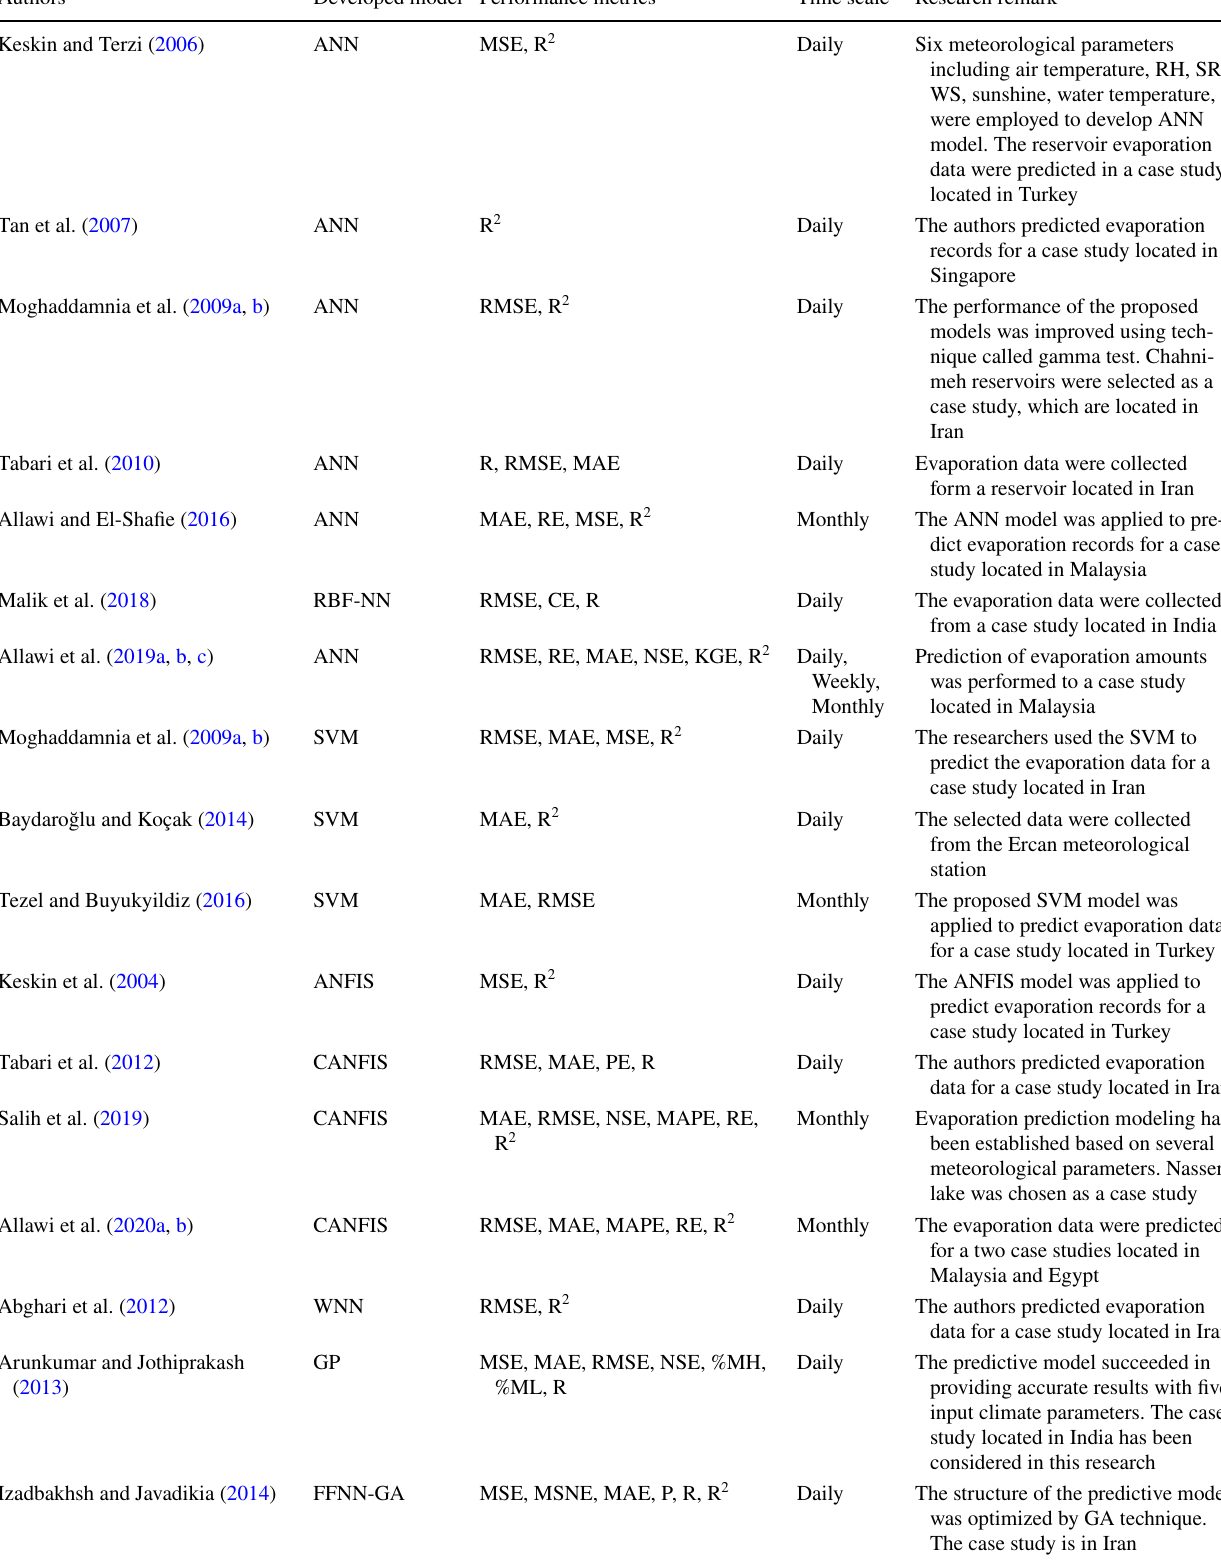
Table 3 Summary of previous studies that were established to model reservoir evaporation prediction using AI